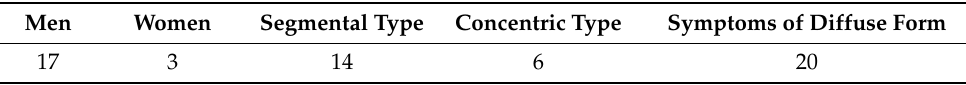
Table 1. Division of cases according to lateral asymmetry of the pelvic plexus. Men (17) Women (3) Right Left Right Left 12 2 Table 2. Division according to the type of formation of peripheral